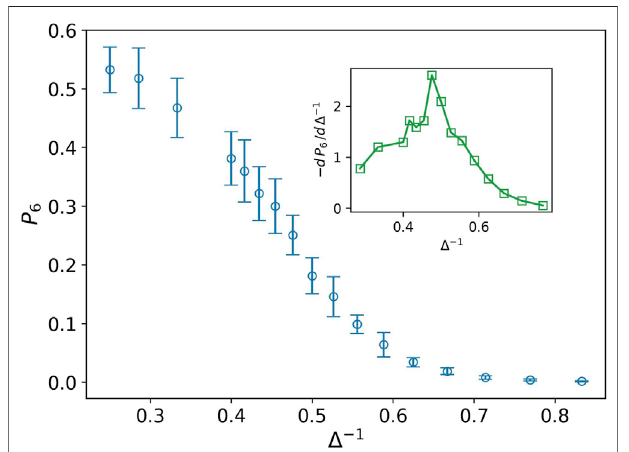
FIGURE 4 | Fraction of nodes with degree six P 6 (blue circle) against the inverse of attraction strength, and the attraction range has a fi xed value, σ = 1.5. The error bars are the standard deviation of sampling over 20 simulation runs. The decreasing behavior shows lack of stiffness. The inset plot displays derivative of P 6 as well. The peak splits solid-like and liquid-like phases.